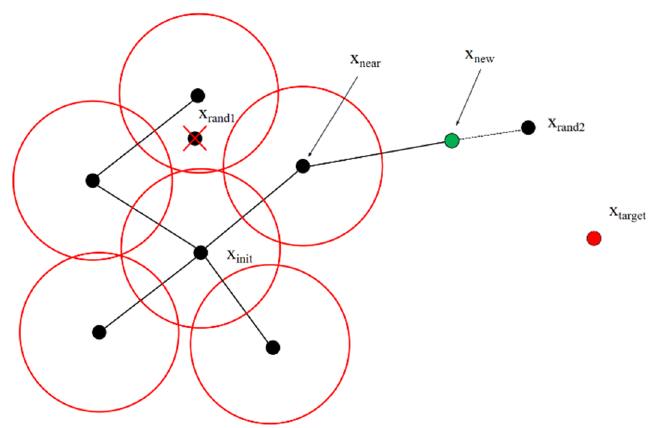
Figure 2. Schematic illustration of the invalid expansion caused by RRT’s random sampling strategy. x rand is the randomly sampled point, x _ near is the nearest neighbor of x rand , and x new is the expansion point. Unfortunately, this step of expansion is invalid because the random tree is not brought close to the target point or expanded to a new area.